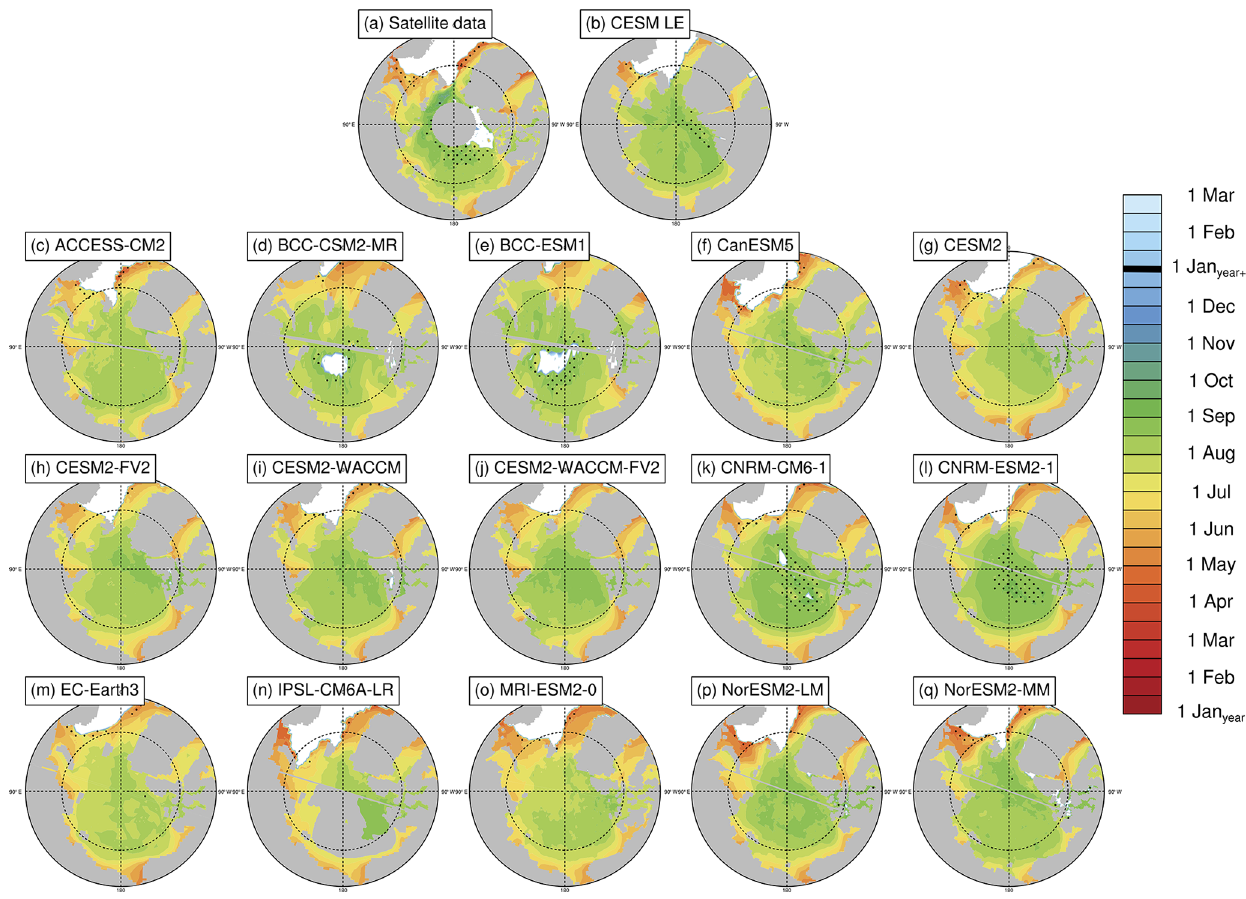
Figure 3. Opening dates (80% ice concentration threshold) averaged over the period 1979–2014 at each grid cell using satellite data (a) , the first ensemble member of the CESM LE (b) , and the first ensemble member of each CMIP6 model (c–q) . Stippling indicates where opening dates exist in less than 20% of years in the time range. Models on tripolar grids produce plot gaps filled by gray